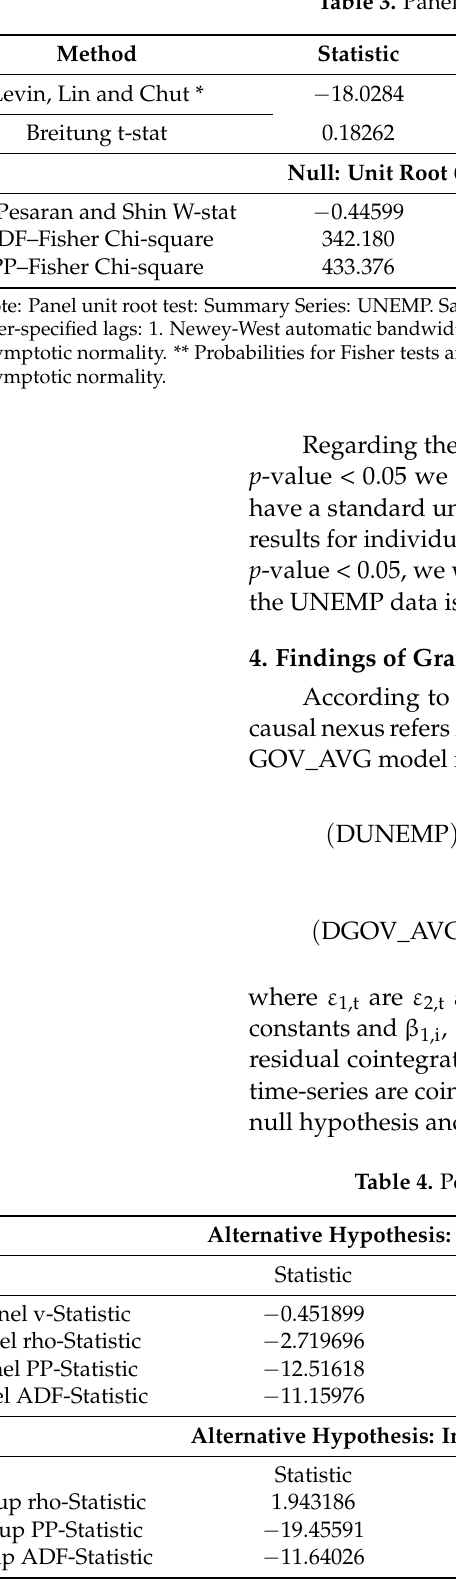
Table 3. Panel unit root test for UNEMP time series.